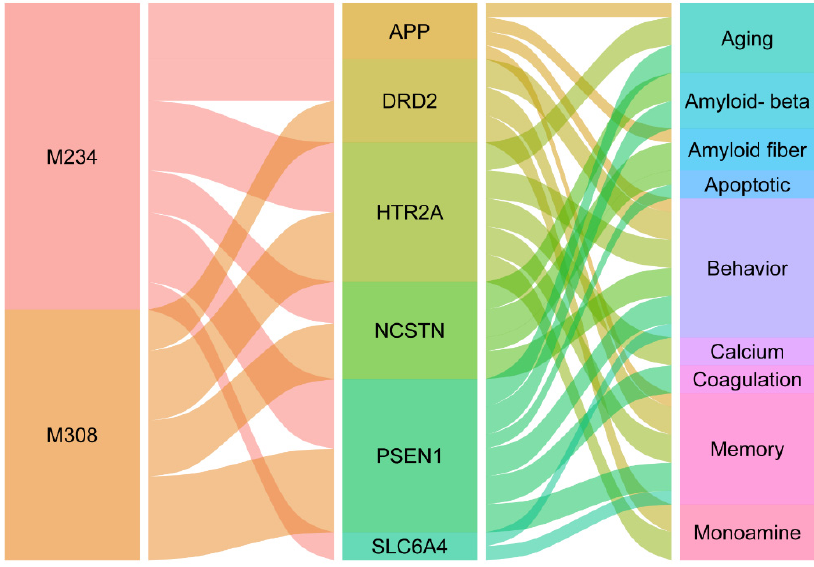
Figure 7. The alluvial plot of compound-target-pathway for M234 and